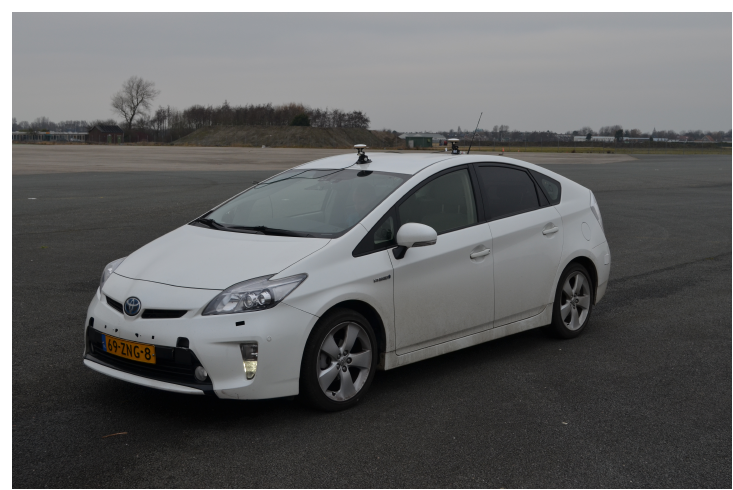
Figure 1. The Toyota Prius used for this work (the two devices on the roof of the vehicle are part of the Spatial Dual GPS).